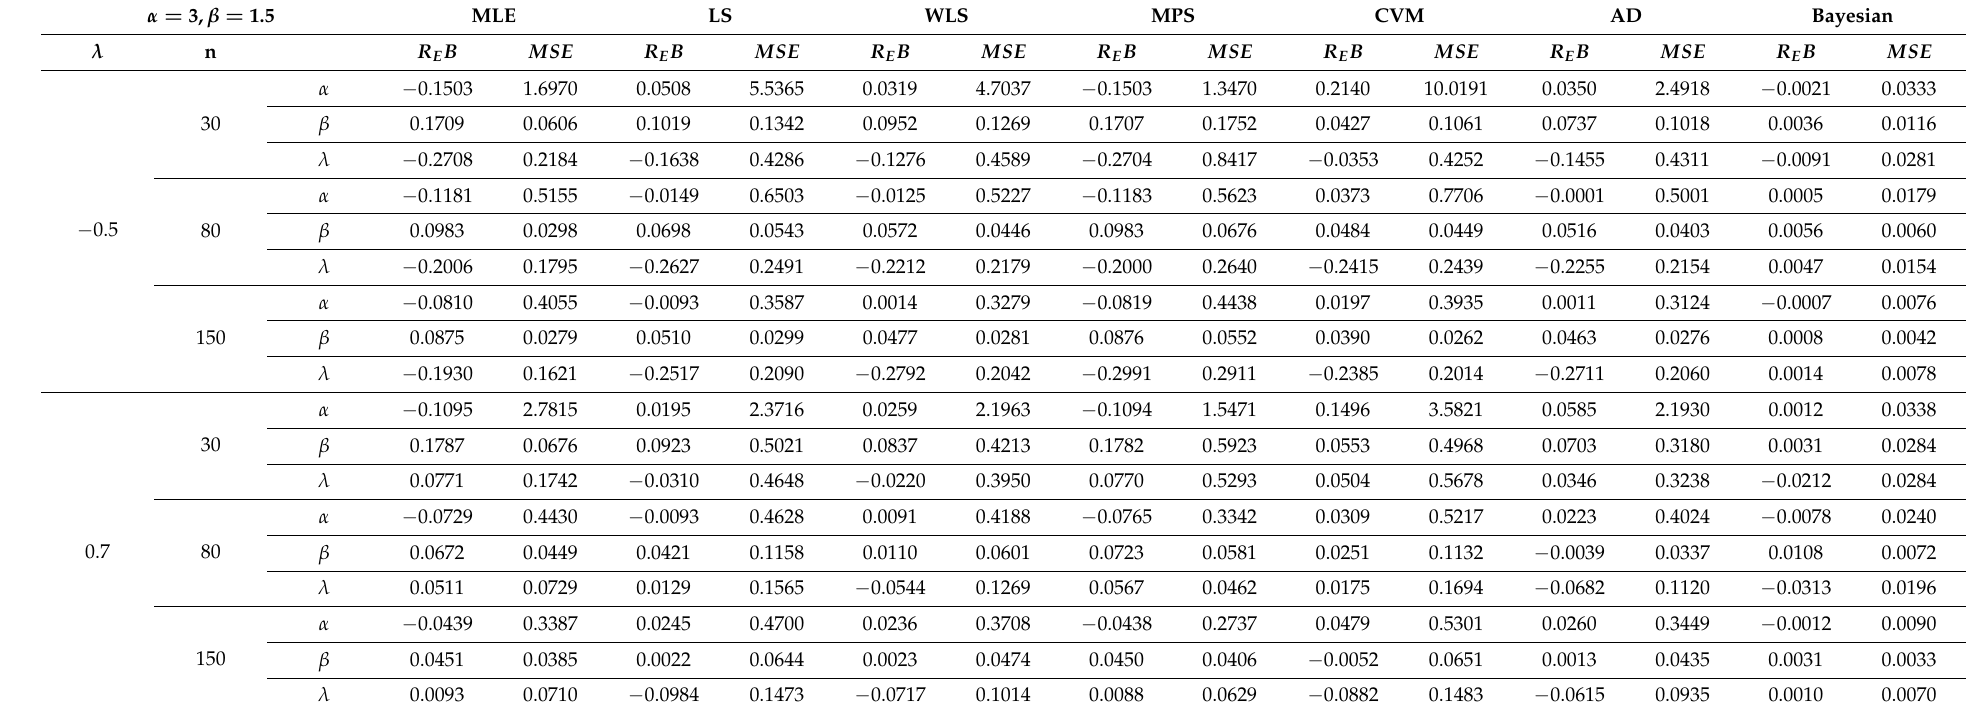
Table 4. Numerical outcomes of R E B and MSE for all estimation approaches at Case